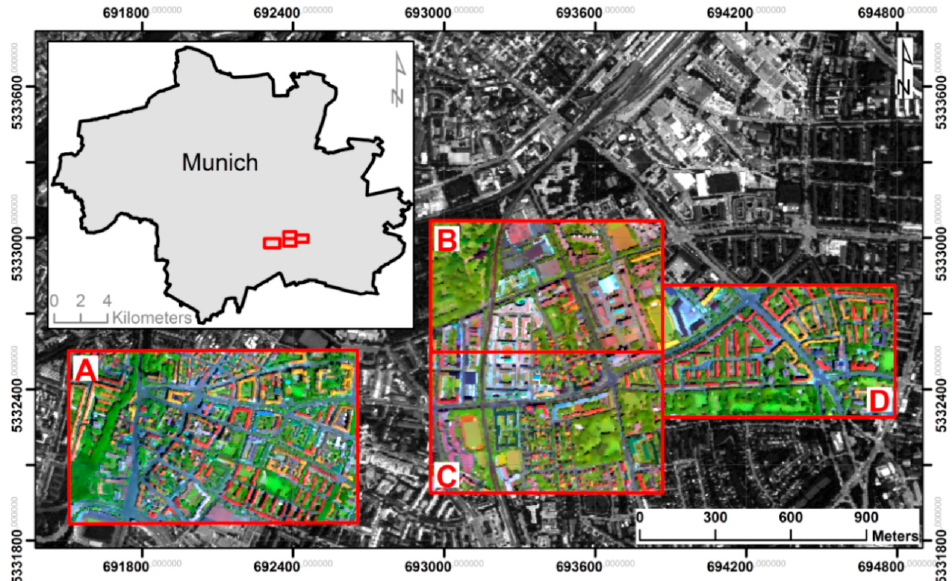
Figure 2. Study area and imaging spectroscopy (HyMap) data for the four test sites A, B, C, and D in Munich, Germany (R = 1652 nm, G = 719 nm, B = 543 nm).